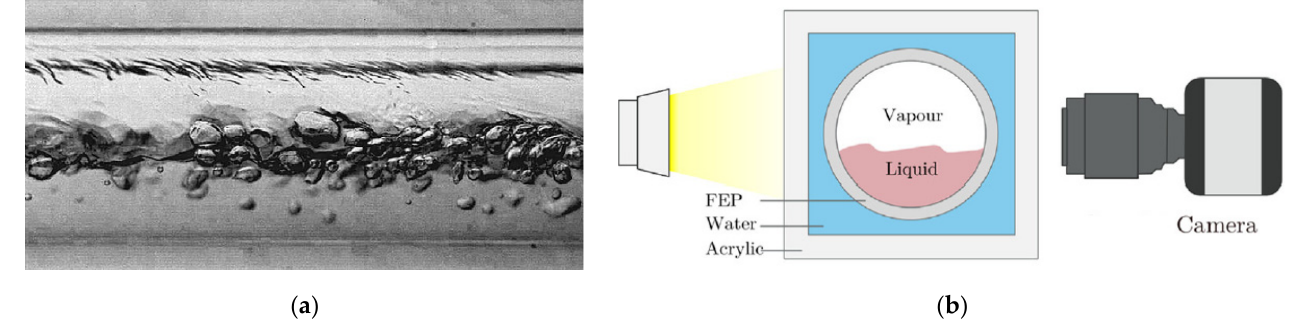
Figure 6. ( a ) Bubbles preventing the interface detection in boiling stratified gas ‒ liquid flow [87]; ( b ) A sketch explaining how the image was obtained [87].